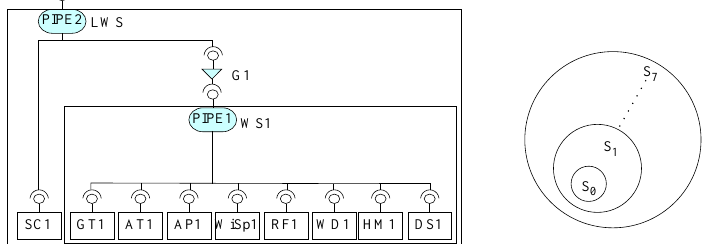
Figure 28. Construction of linked weather station (LWS) composite